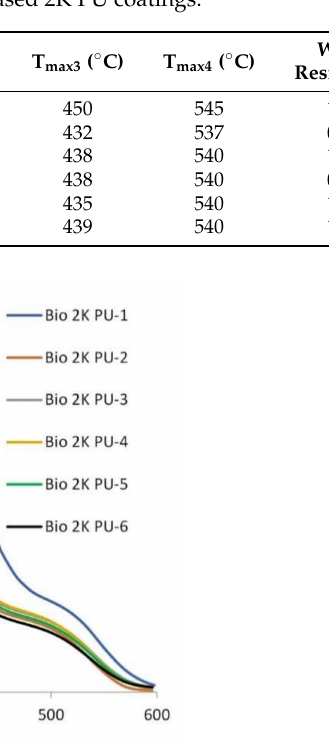
Table 7. Overview of T5%, maximum decomposition temperatures (Tmax) for the different degrada- tion steps and the weight residue at 600 ◦ C for the bio-based 2K PU coatings.